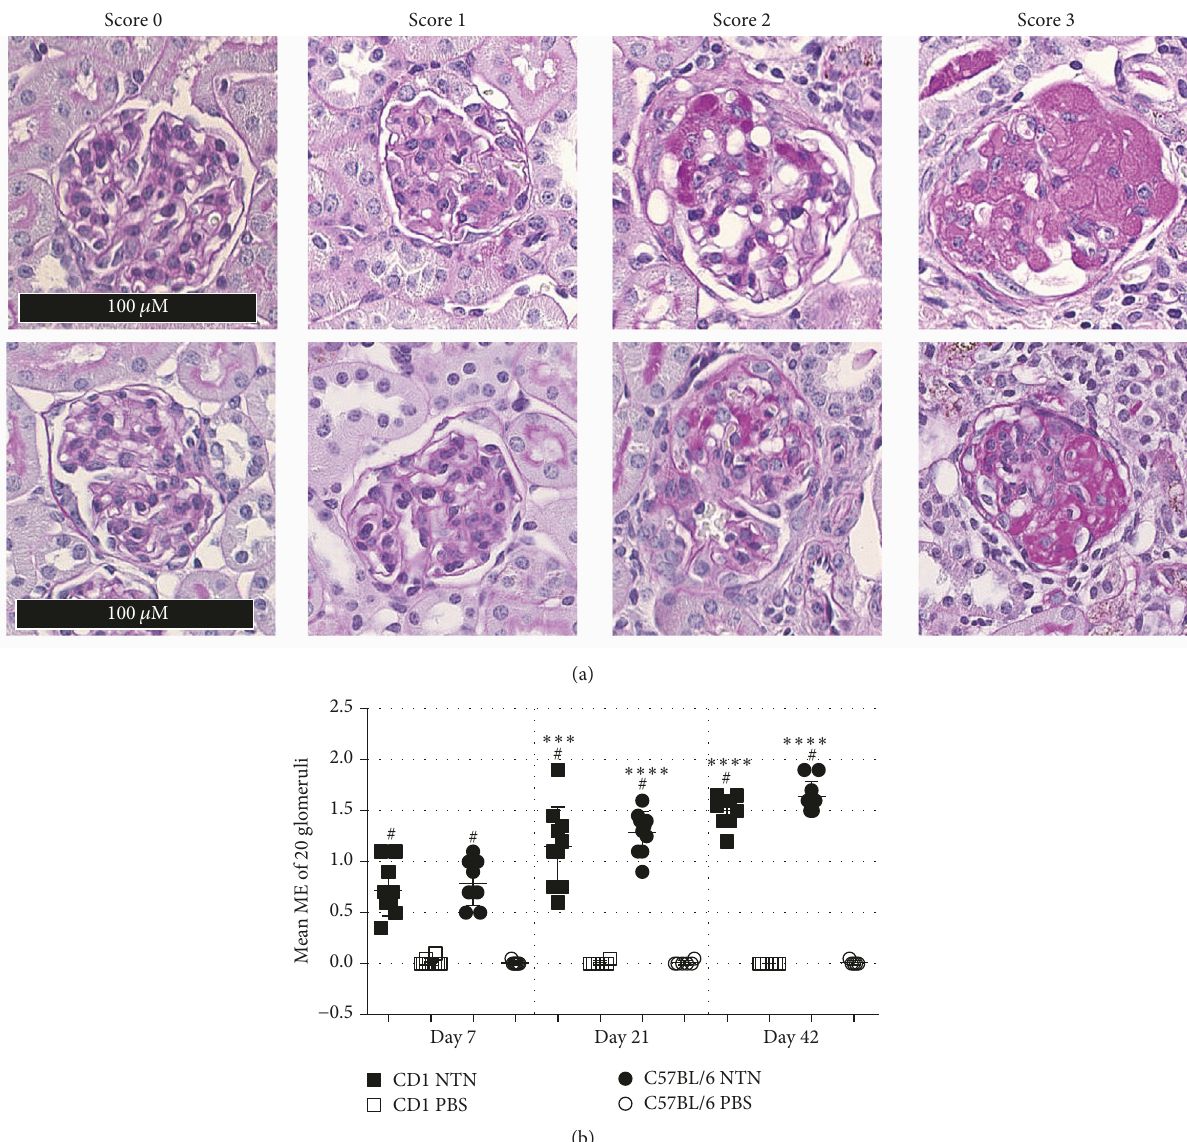
Figure 7: NTS causes chronic and progressive glomerular mesangial expansion in C57BL/6 and CD1 mice . (a) Representative glomeruli showing scores 0, 1, 2, and 3 of mesangial expansion. (b) Scatter plot showing the mean glomerular mesangial expansion (ME) score on days 7, 21, and 42. Data are shown as mean ± SD. # 𝑃 < 0.0001 NTN groups versus PBS groups; ∗∗∗ 𝑃 < 0.001 NTN group day 7 versus NTN group day 21; ∗∗∗∗ 𝑃 < 0.0001 NTN group day 21 versus NTN group day 42 by two-way ANOVA and using Kruskal-Wallis multiple testing ( 𝑛 = 10 ).